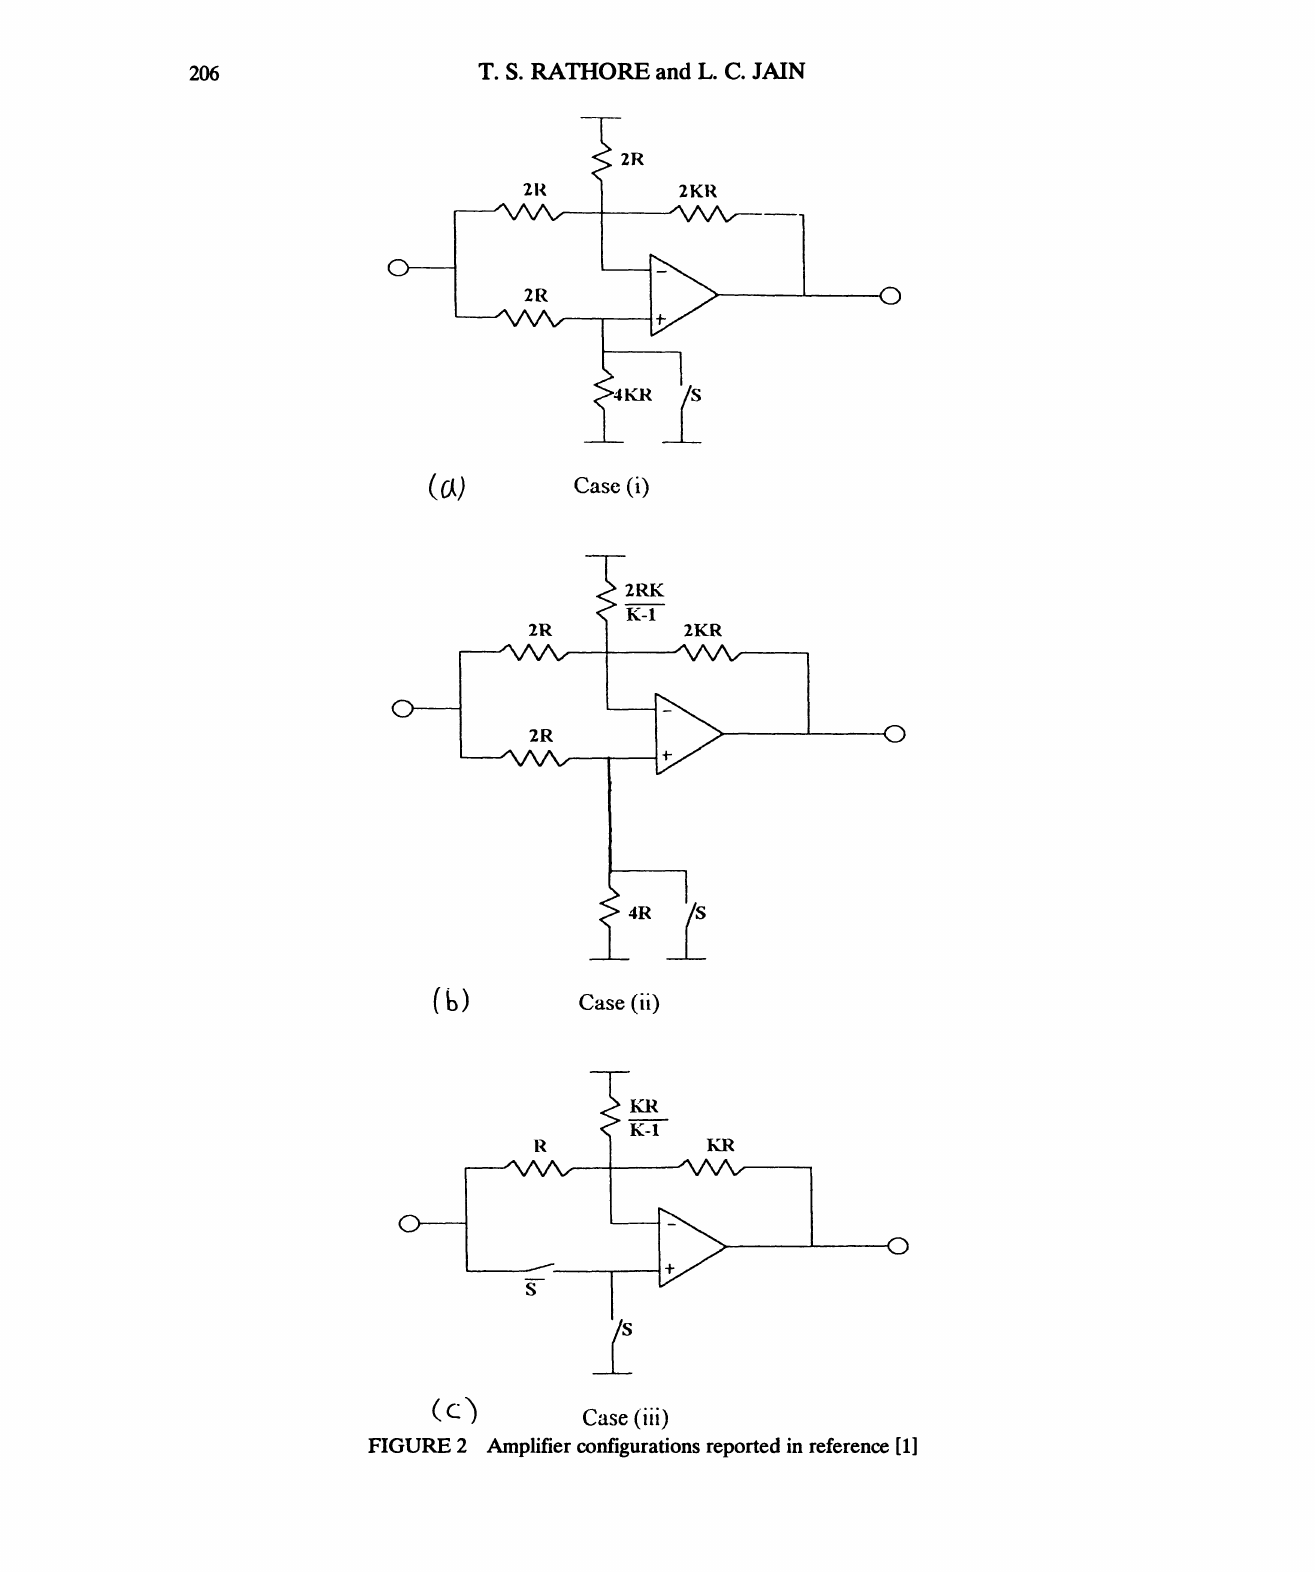
Case (iii) Amplifier configurations reported in reference